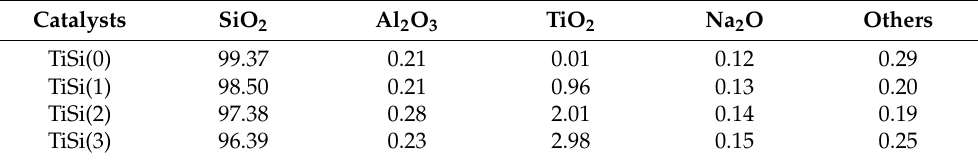
Table 1. Elemental composition of mesoporous silica catalysts with different titanium contents. Catalysts SiO 2 Al 2 O